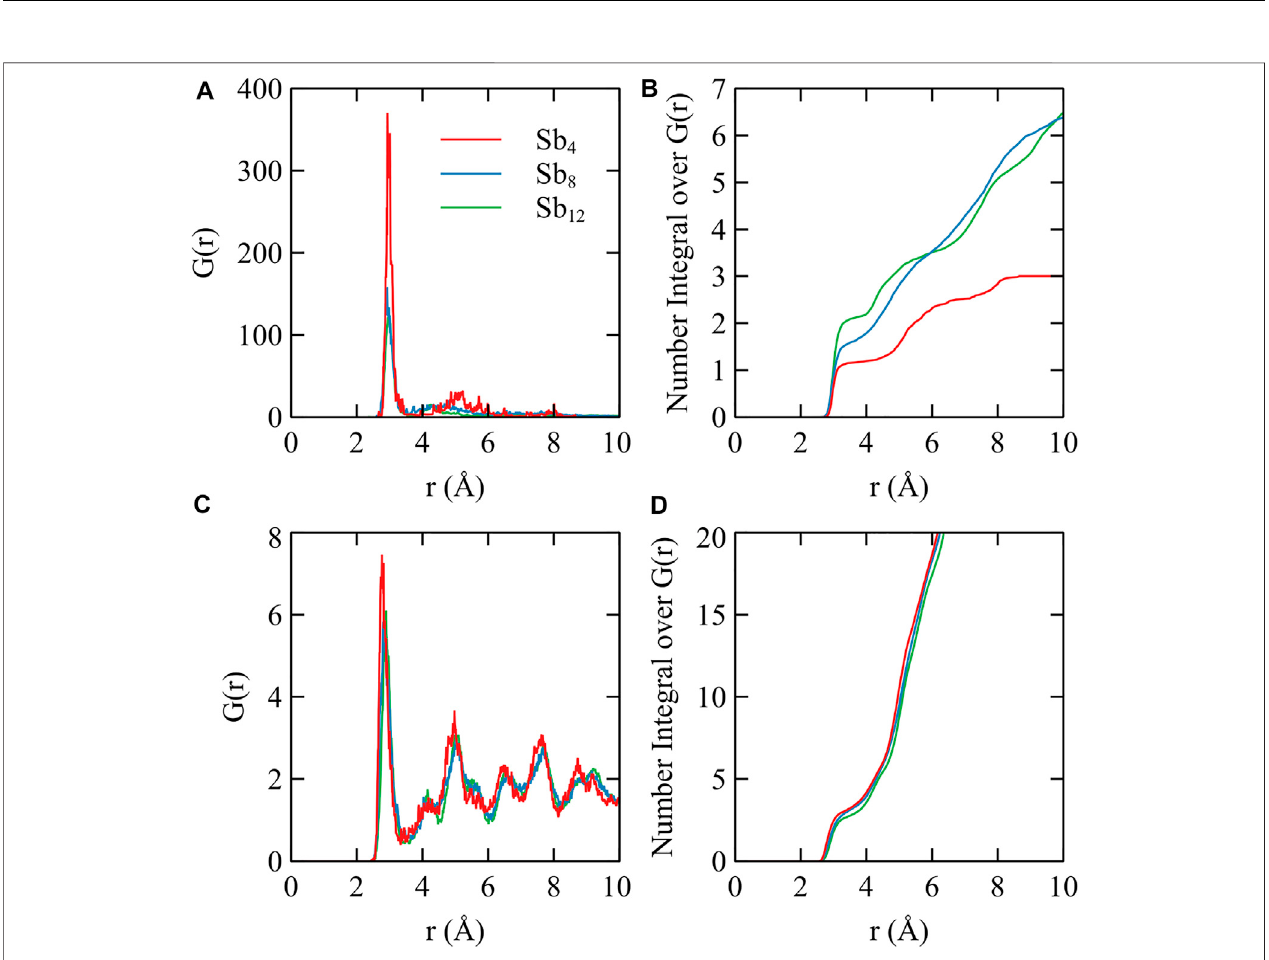
FIGURE 7 | (A) and (C) are the radial distribution function for Sb – Sb and Sb – Ag, respectively. (B) and (D) are integration curve of (A) and (C) . The line in red, blue, and green correspond to one, two, and three Sb 4 clusters on the Ag (111) substrate, respectively.